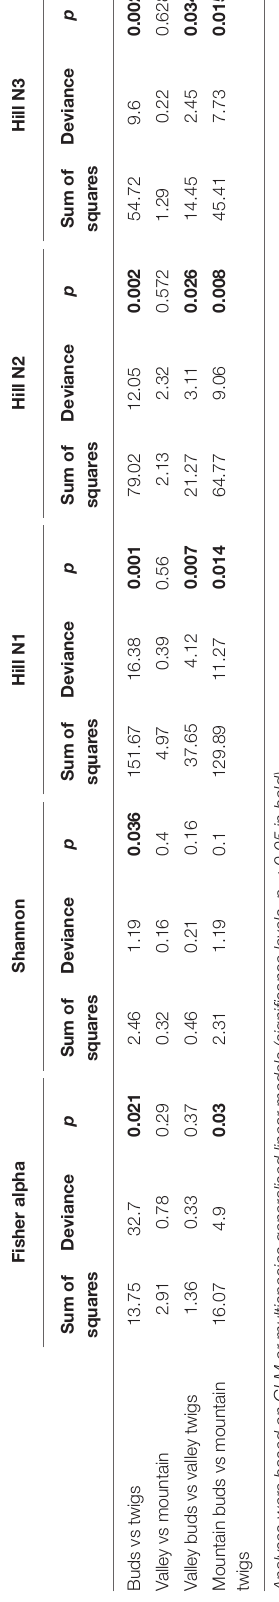
of the multivariate generalized linear model showed ( Table 1 ) that buds and twigs differed significantly ( p < 0.05, indicated in bold) for all five diversity indices. This substantial difference between the two substrates was consistent between the two sites and across all diversity measurements ( Figure 2A and Supplementary Figure 2 ). On the other hand, the